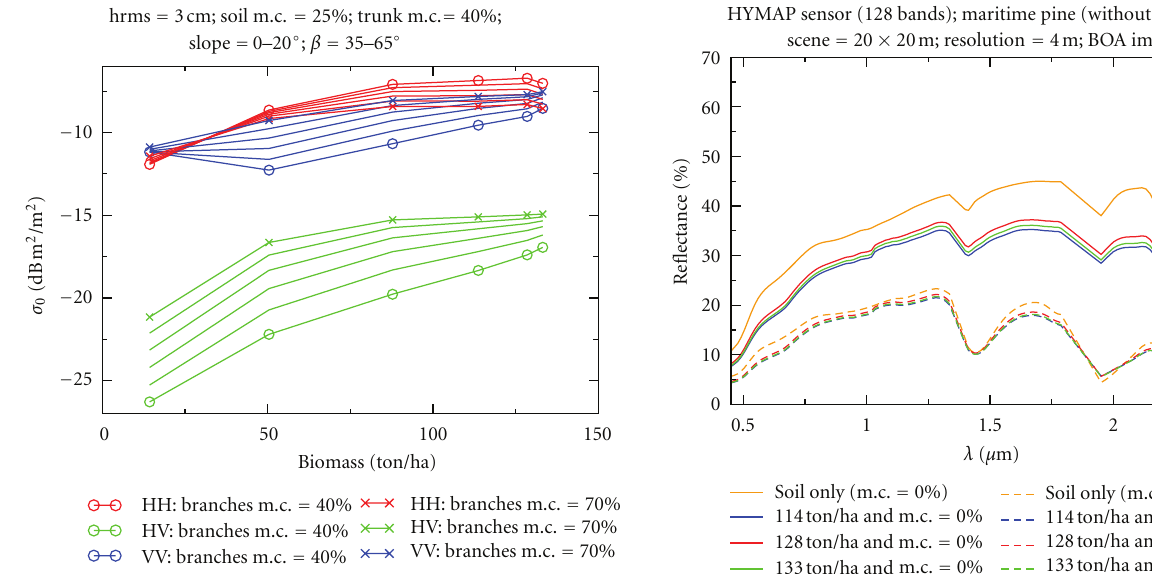
Figure 7: Reflectance spectra simulated for several ages of forest and a mineral soil with a 0% m.c. for the first one and a 39% m.c. for the other one. In addition, the measured reflectance spectra of the soil for both m.c. are displayed in